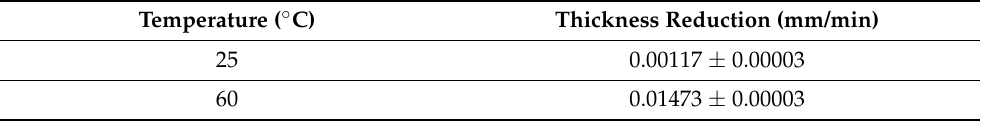
Table 6. Reduction of aluminum A1 thickness as a function of temperature in 7.5 M